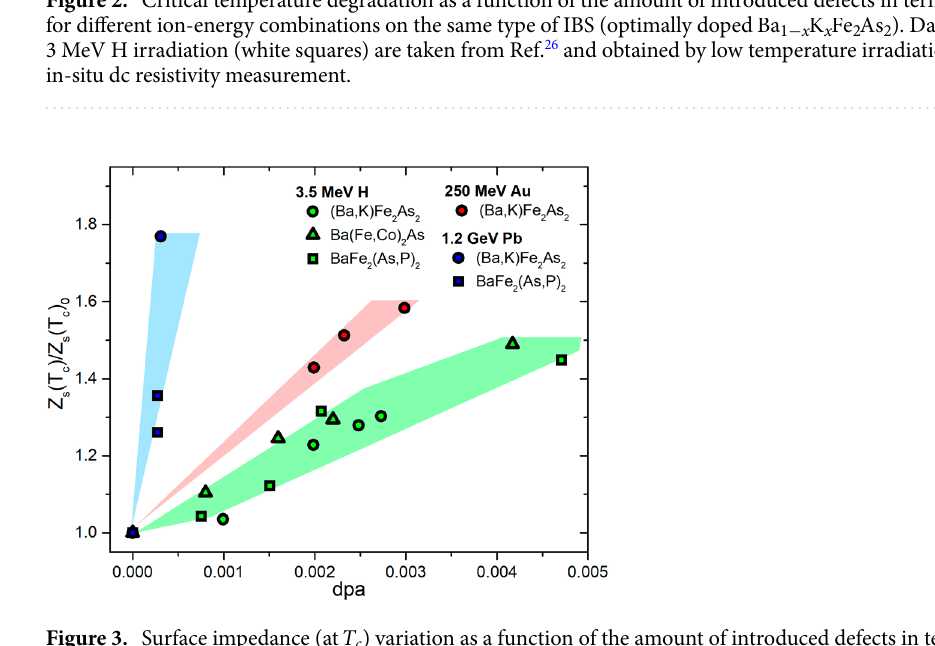
Figure 3. Surface impedance (at T c ) variation as a function of the amount of introduced defects in terms of dpa for different irradiation ion-energy